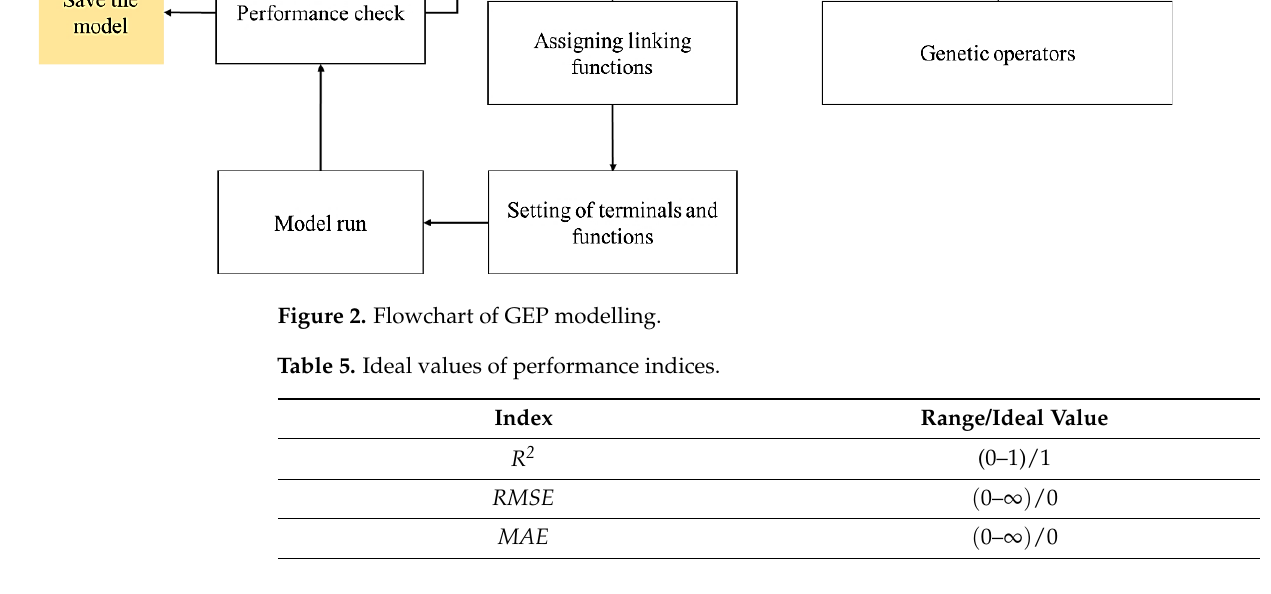
Table 5. Ideal values of performance indices.